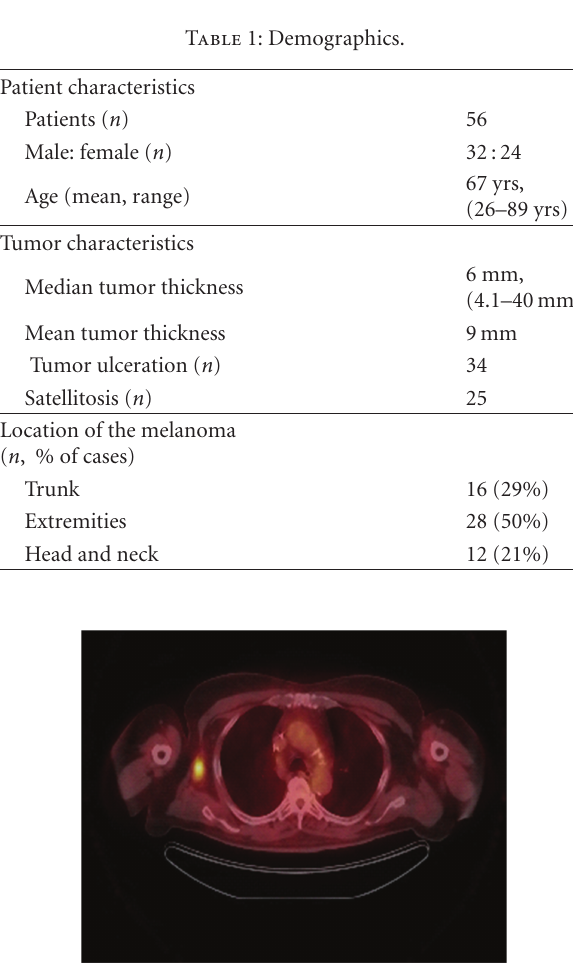
Figure 1: Lymph node uptake.